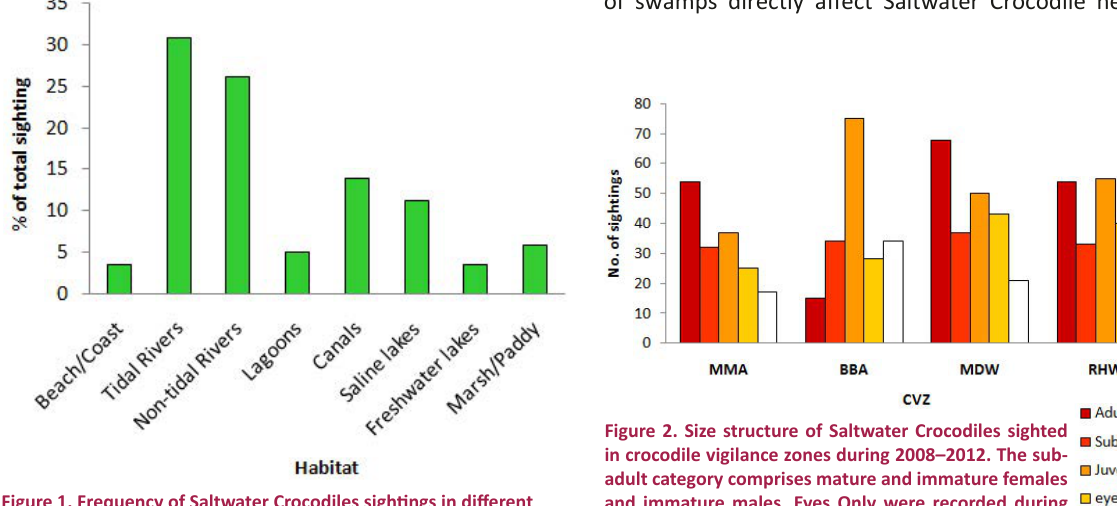
Figure 1. Frequency of Saltwater Crocodiles sightings in different habitats during 2008–2012